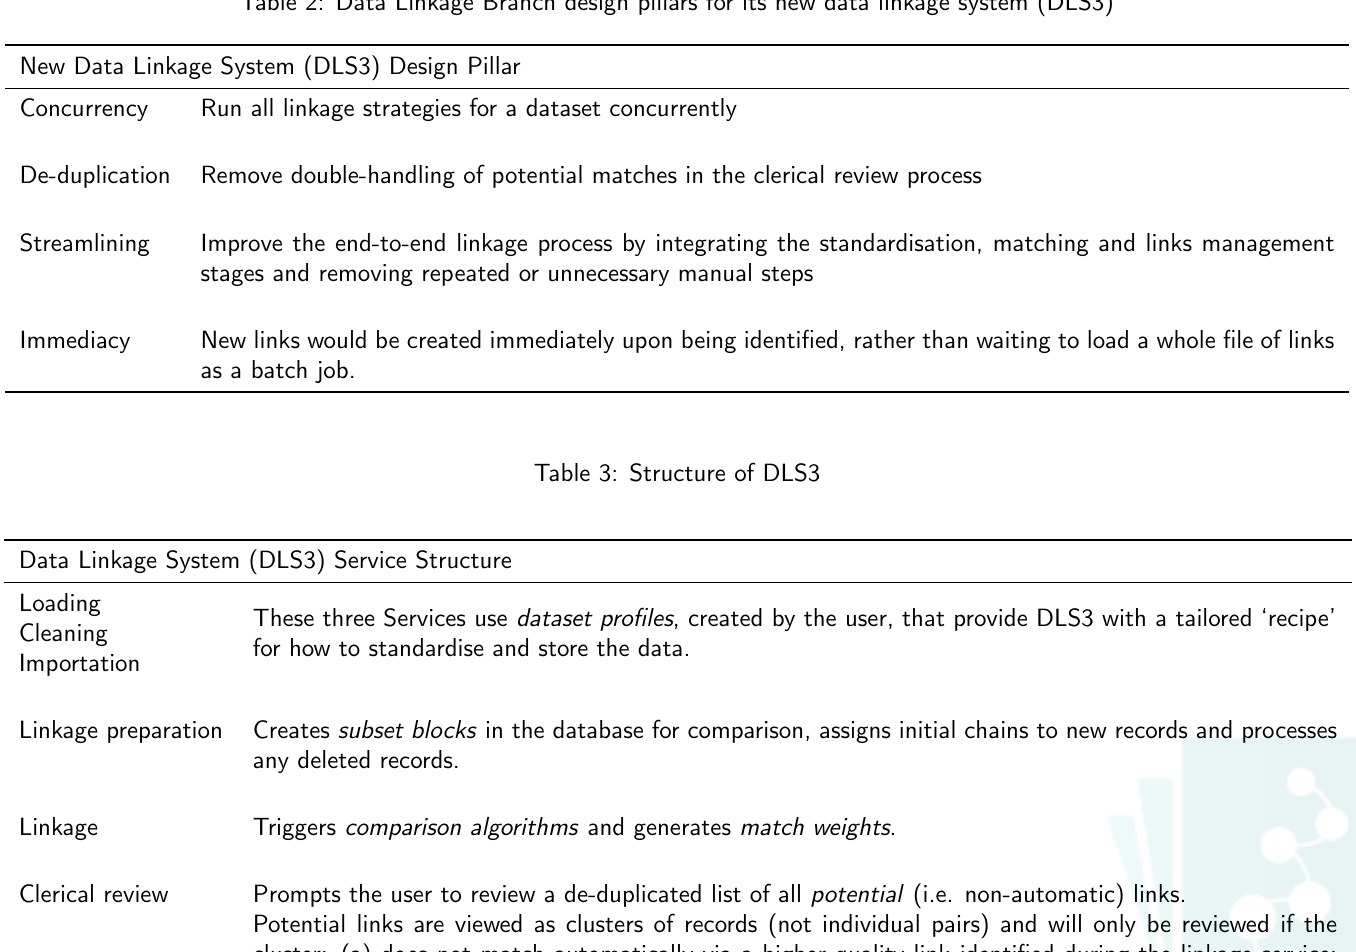
Table 2: Data Linkage Branch design pillars for its new data linkage system (DLS3)